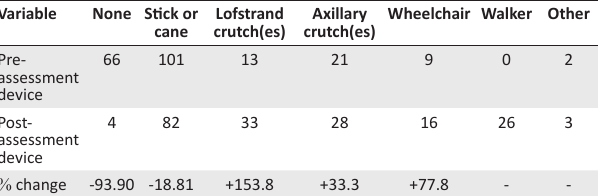
TABLE 4: Pre- and post-assessment device usage.